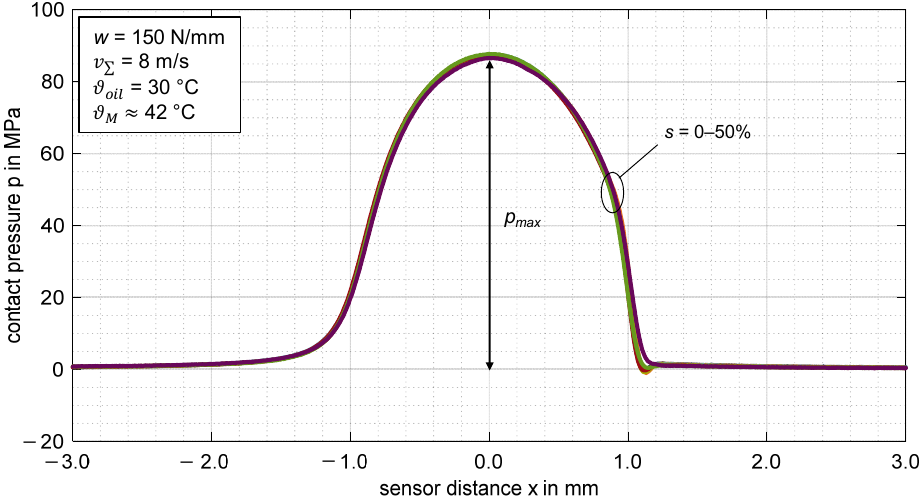
Figure 5. Measured contact pressure for the thermoplastic EHL contact ZrO 2 /PEEK (line load w = 150 N/mm, sum velocity v ∑ = 8 m/s, slip ratios s = {0; 5; 10; 20; 30; 40; 50}%, oil temperature ϑ oil = 30 ◦ C, MIN100).